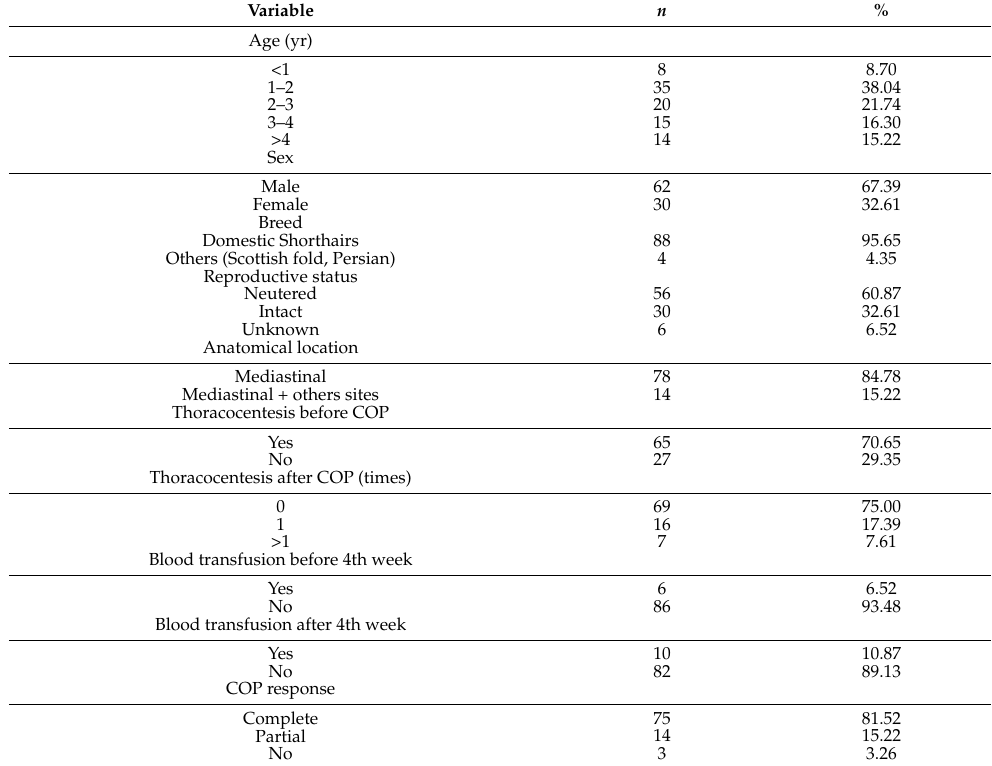
Table 1. Patient